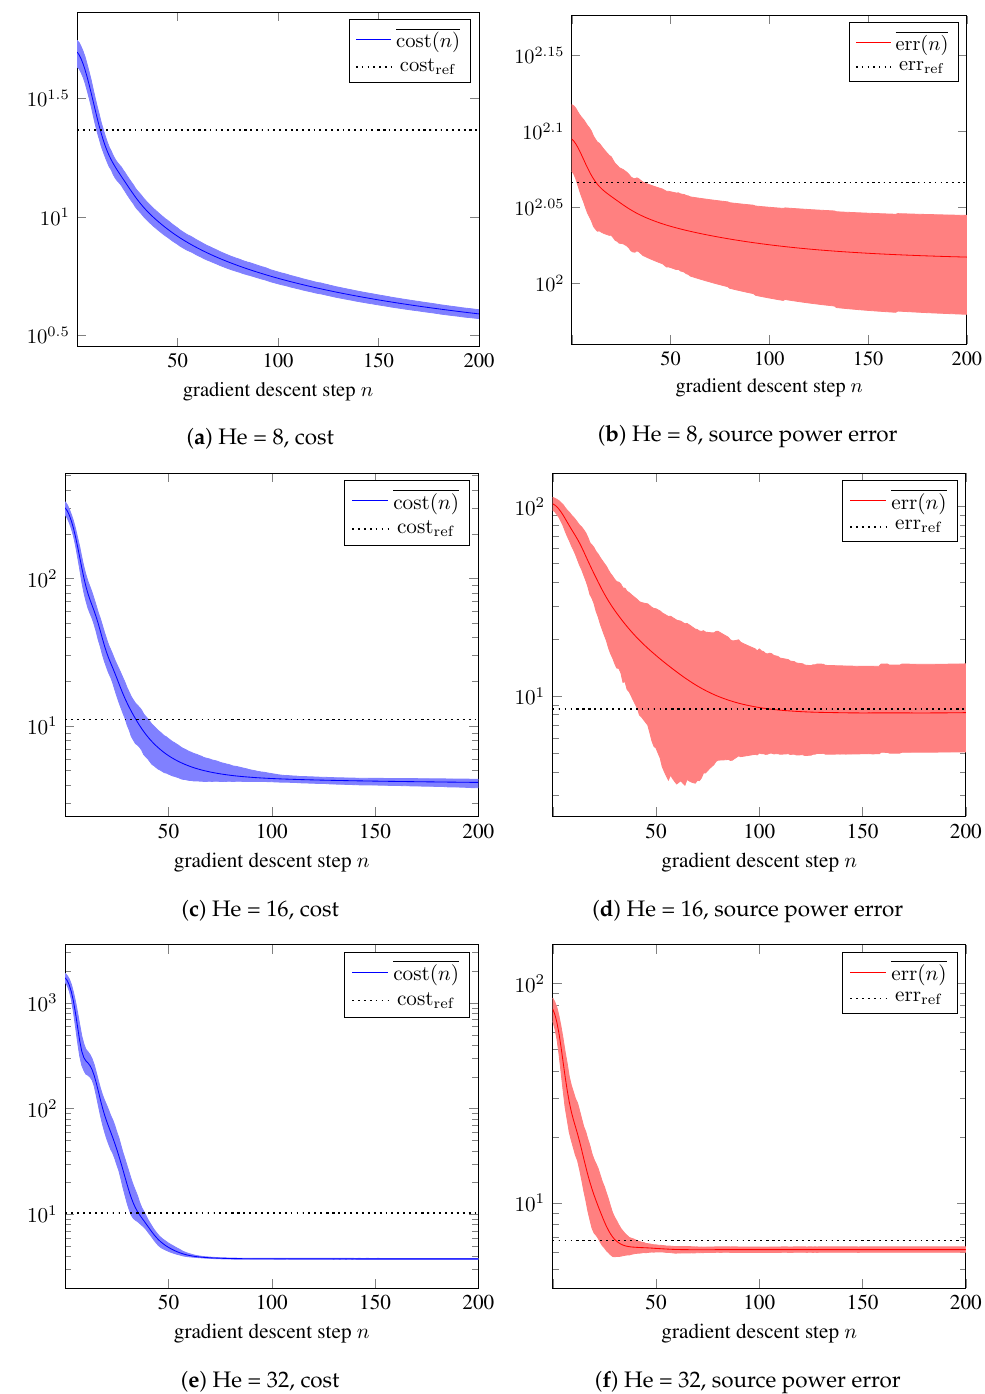
Figure 5. Cost and error graphs for several Helmholtz numbers. The colored area indicates the interval cost ( n )